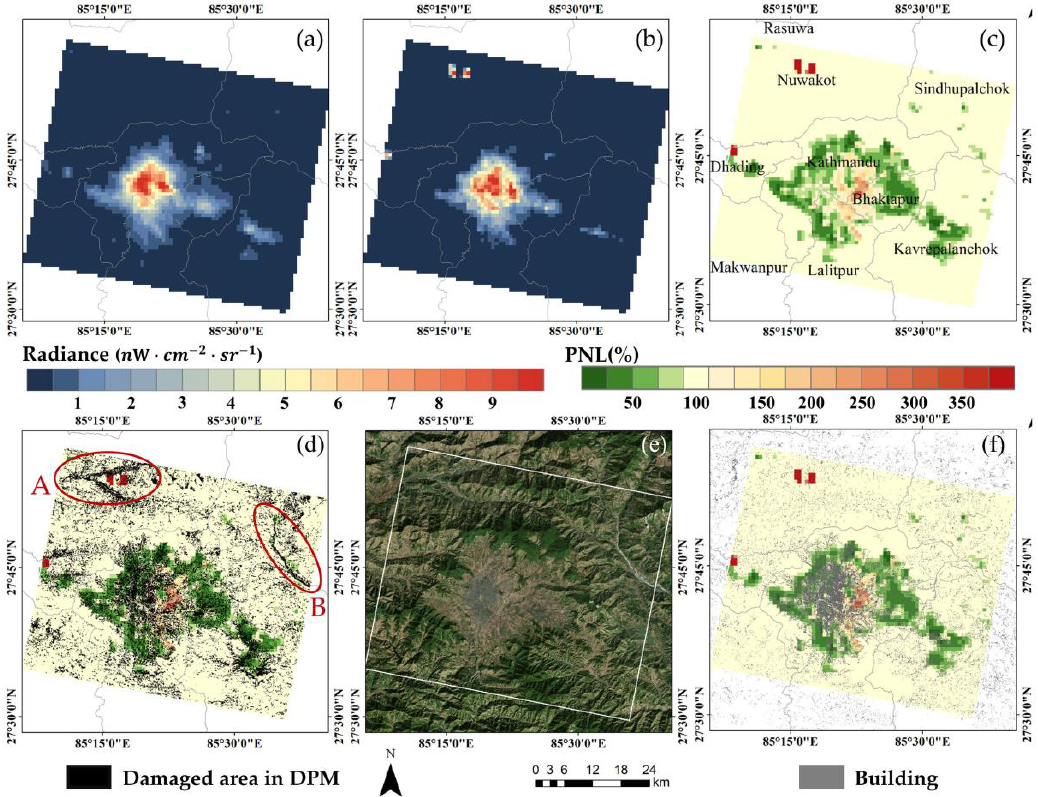
Figure 3. ( a ) The pre- and ( b ) post-earthquake averaging composite DNB images, ( c ) Percent of Normal Light (PNL) image, ( d ) Damage Proxy Map (DPM) image combined with PNL image, ( e ) Bing satellite map, and ( f ) Open Street Map (OSM) building map combined with PNL image of the Gorkha Nepal Earthquake.